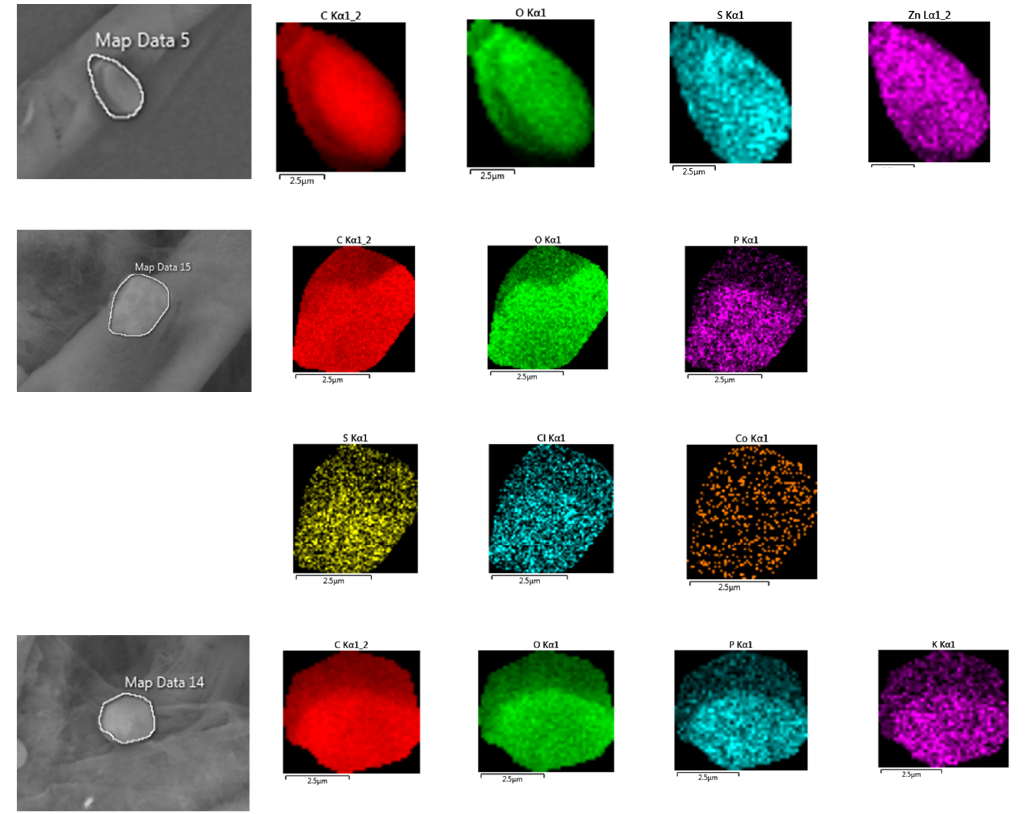
Figure 5. Spatial elemental distribution in combustion particulates (tar balls). Grey image on the left is the BSE image showing the particle shape while the colour images observed by EDS x-ray microprobe show elemental distribution per single element (stated with measured X-ray emission line above the image) across the particle.